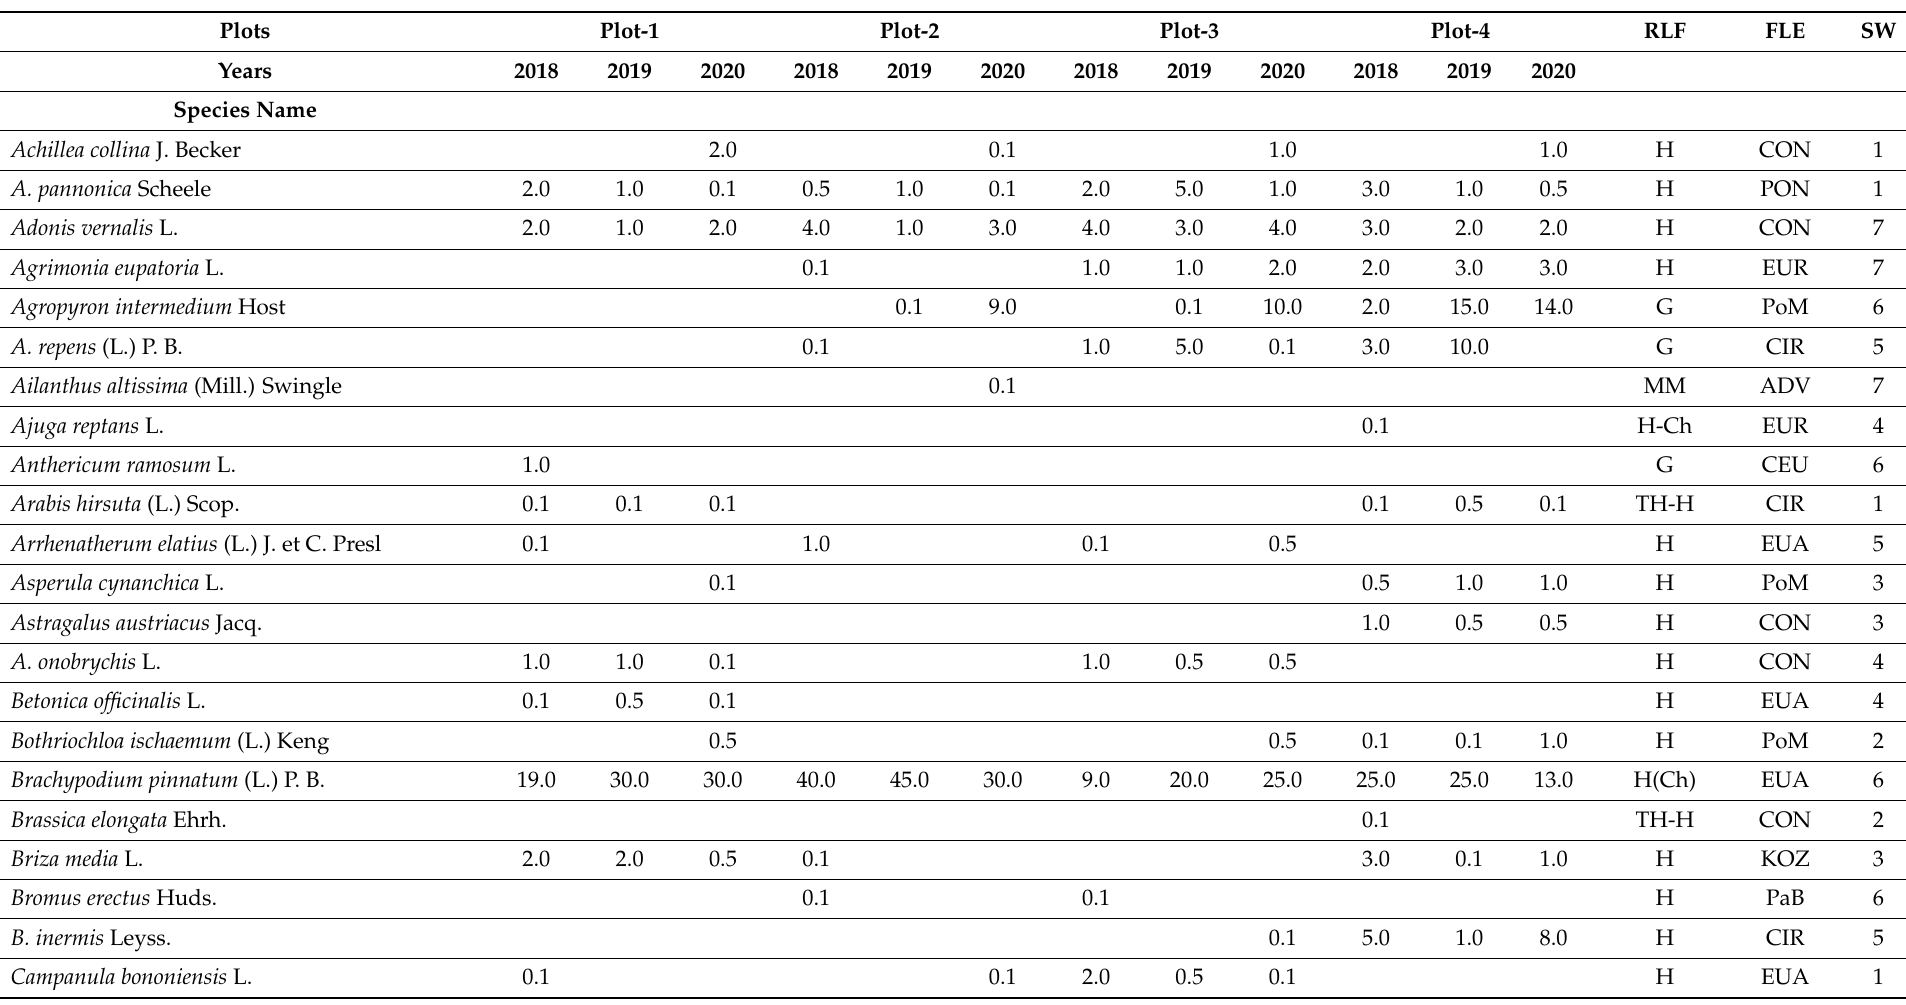
Table A1. List of species with their cover values in the Natura-2000 loess grassland at “P ó calja”, Central Hungary, in the years 2018–2020. Plots Plot-1 Plot-2 Plot-3 Plot-4 RLF FLE SW